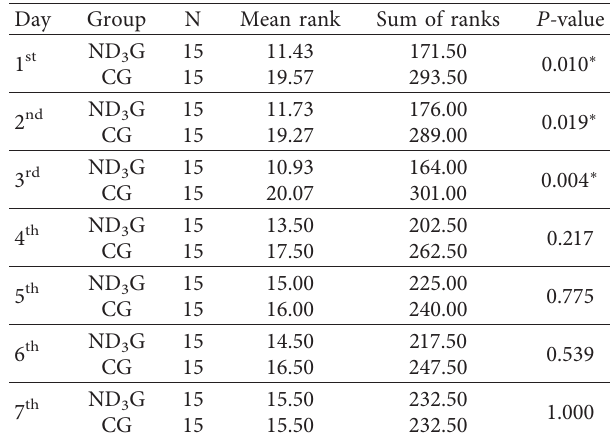
Table 6: Mann–Whiteny U test comparing pain perception for the first seven